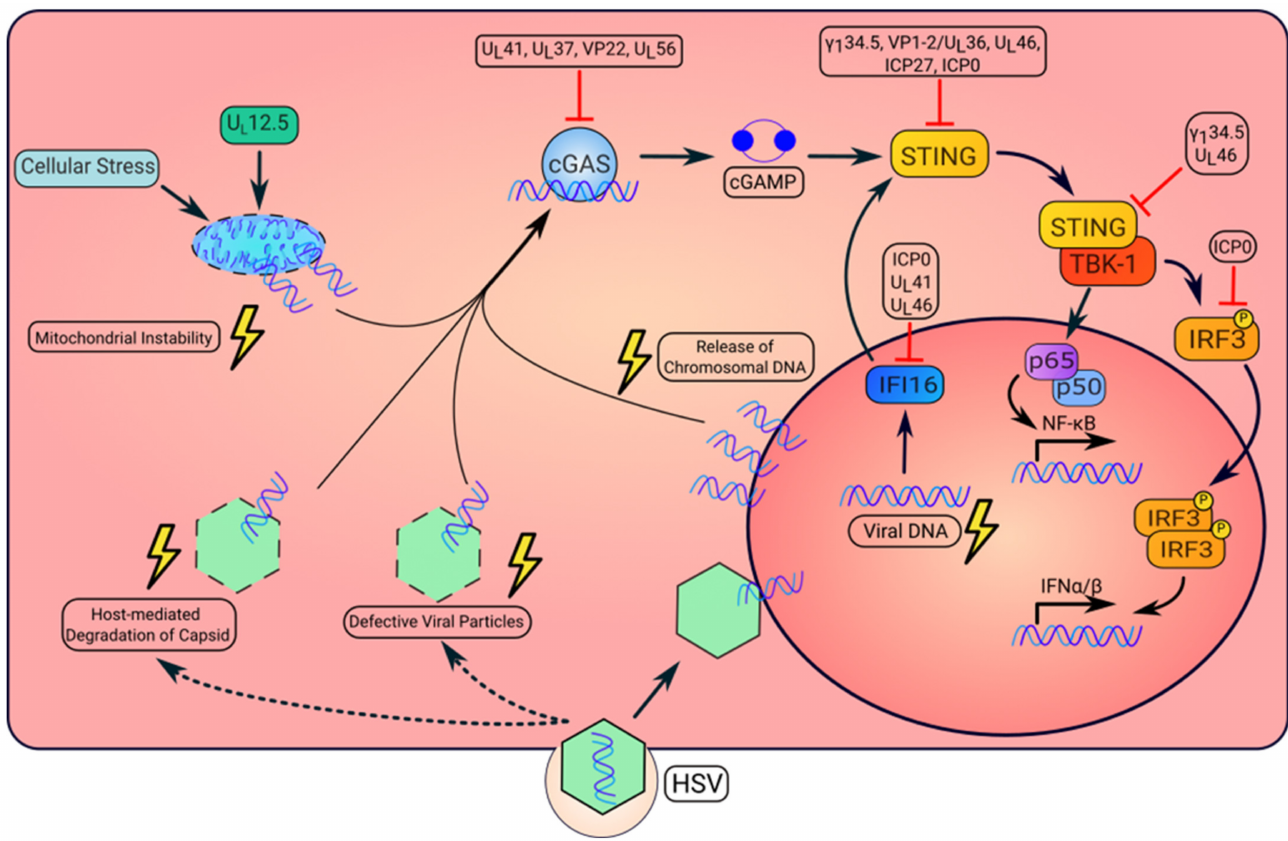
Figure 1. Activation and repression of the STING pathway by HSV. HSV infection can result in the altered localization of viral or dsDNA that is detected by intracellular DNA sensors. First, in the initial stage of infection, defective capsid can result in leakage of the viral genome into the cytosol. Additionally, proteasomal-dependent degradation of viral capsid may allow for release of the viral genome into the cytosol. Upon recognition of viral DNA, cGAS synthesizes the cyclic dinucleotide, cGAMP, that will bind to and activate STING. Once activated, STING recruits TANK-binding kinase 1, TBK1. This kinase complex phosphorylates the transcription factor, IRF3, resulting in its dimerization and nuclear translocation to induce type I IFN. STING also mediates the activation of NF- κ B to produce inflammatory cytokines. Second, the virally encoded gene product UL12.5 can also induce mitochondrial instability resulting in release of mtDNA to the cytosol, which activates cGAS. Third, HSV replication causes the cytosolic release of host chromosomal DNA, which also activates STING signaling. Moreover, IFI16 senses viral DNA and moves to the cytoplasm where it activates STING. However, HSV expresses several proteins to inhibit STING pathway activation, which enables viral replication or pathogenesis (additional details on viral protein functions in Table